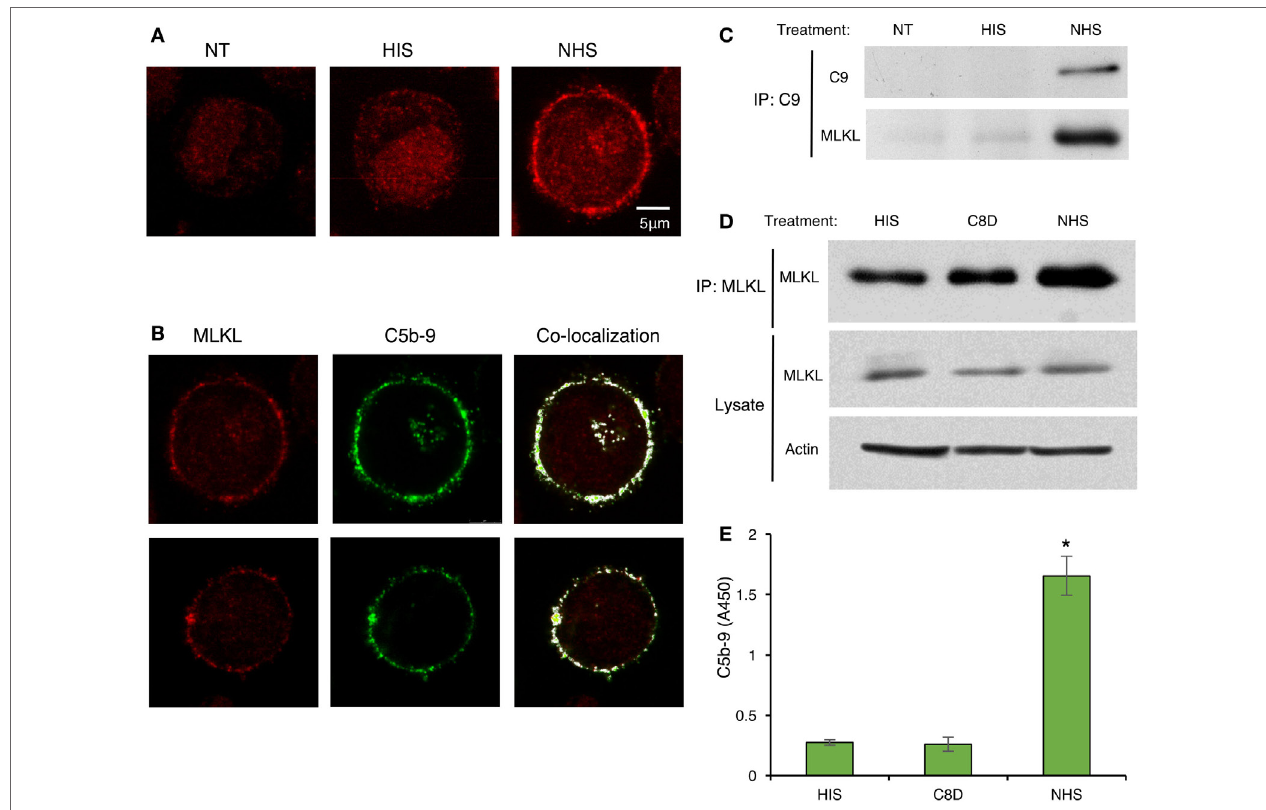
FigUre 6 | C5b-9 deposition triggers mixed lineage kinase domain-like protein (MLKL) translocation to the plasma membrane and C5b-9-MLKL interaction. (a) K562 cells were treated with a sublytic dose of antibody and with complement [normal human serum (NHS)] or HIS for 10 min at 37°C. After fixation and permeabilization, MLKL was stained with anti-MLKL antibody and AF546-labeled secondary antibody. Representative confocal microscope images are presented. NT, non-treated cells. (B) K562 cells were treated with antibody and complement as above. In addition to MLKL labeling, C5b-9 was detected with an anti-C5b-9 antibody (AE-11) and with AF488-labeled secondary antibody. MLKL and C5b-9 locations were merged by the Co-localization plugin in ImageJ software. Representative cells (from three independent experiments) show the co-localization of MLKL with C5b-9 in the plasma membrane region. (c–e) K562 cells were treated with complement (NHS) as above and cell lysates were prepared. Controls included HIS and C8-depleted human serum (C8D). (c) Cell lysates were subjected to immunoprecipitation with anti-C9 antibody followed by Western blot analysis with anti-C9 or anti-MLKL antibodies. (D) MLKL was immunoprecipitated from cell lysates with an anti-MLKL antibody. MLKL was detected by Western blotting. MLKL and actin were also quantified in whole-cell lysates (Lysates). (e) Proteins immunoprecipitated from cell lysates with anti-MLKL antibodies, as in (D) , were eluted from the beads and the amount of C5b-9 was quantified by ELISA. Results are expressed as adsorption at 450 nm (A450). * P < 0.05 relative to C8D or HIS treated cells ( t